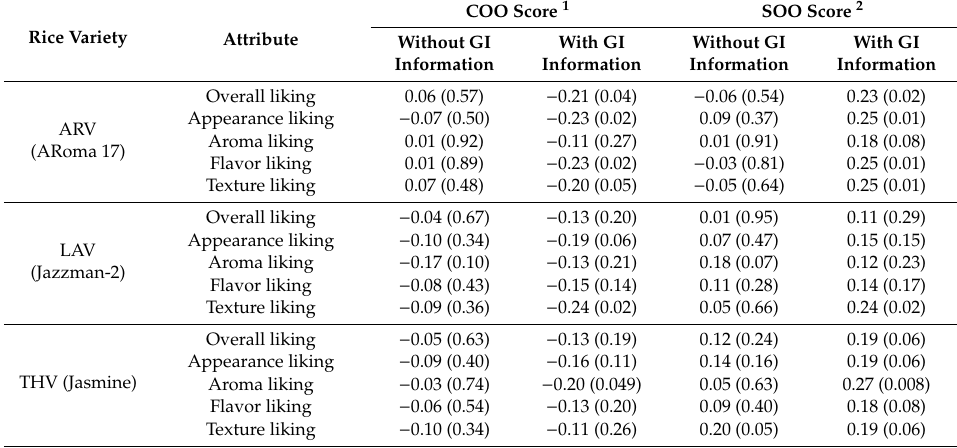
Figure 3. Comparisons between the two geographical indication (GI) information conditions with respect to hedonic ratings of attributes and overall impression across the three cooked aromatic rice samples. * and *** represent a significant difference at p < 0.05 and p < 0.001, respectively. Different letters with mean ratings within a category indicate a significant difference at p < 0.05. N.S. represents no significant difference at p < 0.05. Partial correlation coe ffi cients ( p -value) between the importance levels of either “country-of-origin” (COO) or “state-of-origin” (SOO) scores and hedonic ratings of three aromatic rice samples with respect to GI information